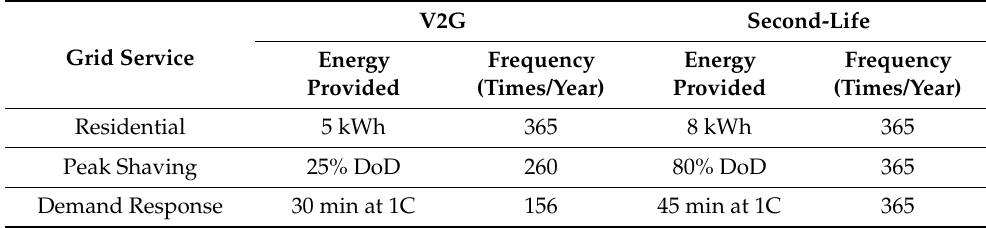
Table 3. Grid service parameters